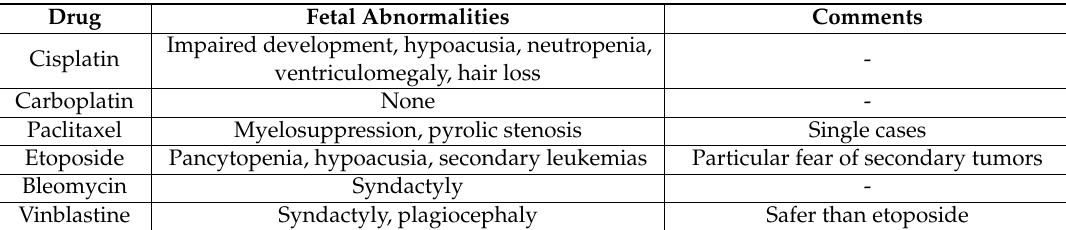
Table 4. Toxicity of the most used chemotherapeutics and their influence on the fetus